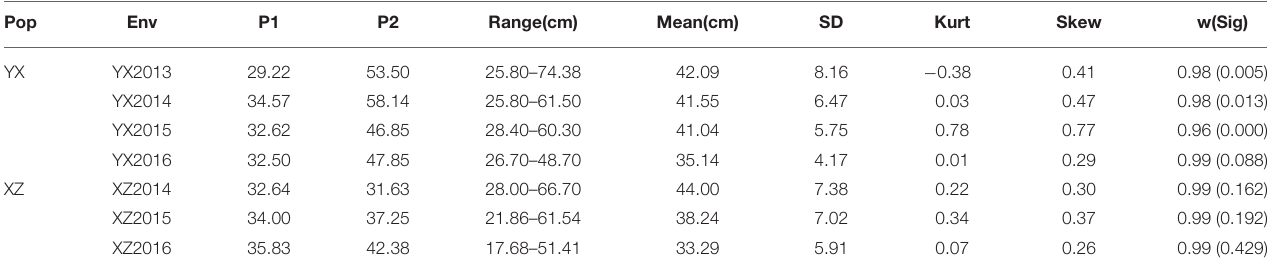
TABLE 1 | Descriptive statistical analysis for plant height (cm) in two RIL